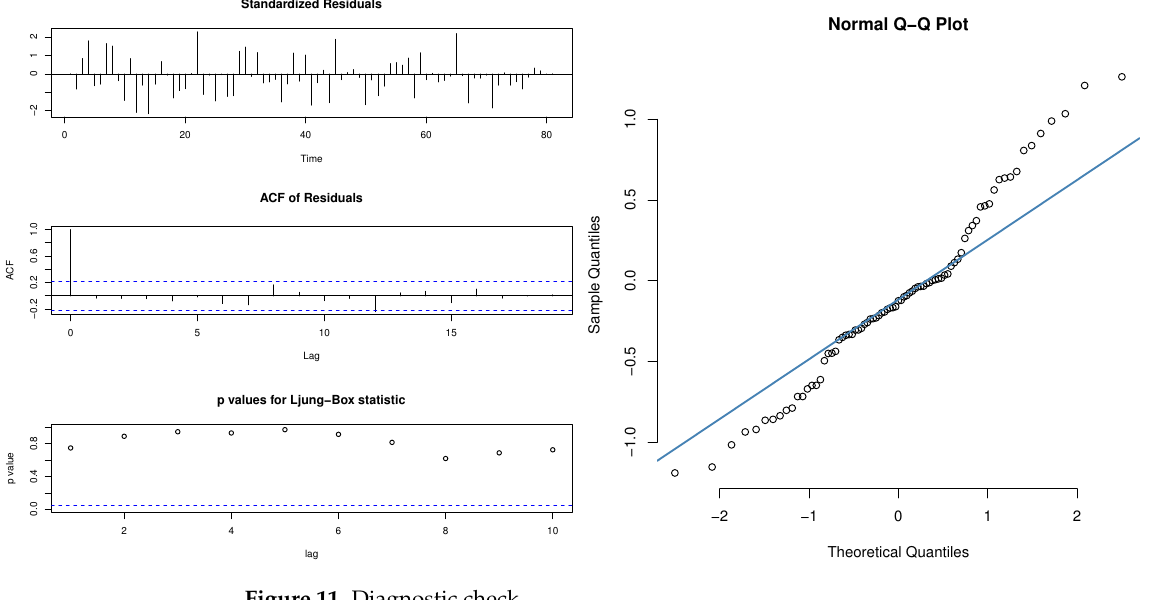
Figure 11. Diagnostic check.